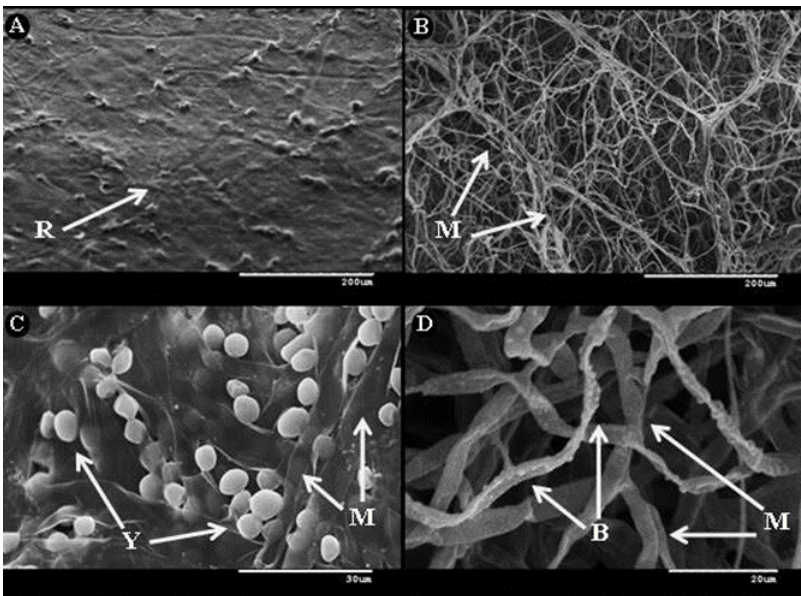
Figure 5. Micrographs from the scanning electron microscope of the inoculated roots of ancho-type pepper plants with Pythium ultimum and marine microorganisms. ( A ) Root (R) without microorganisms; ( B ) Oomycete Mycelium (M); ( C ) Cryptococcus laurentii (Y) 2R1CB; and ( D ) Bacillus subtilis (B) RBM02; both adhered to P. ultimum mycelium.